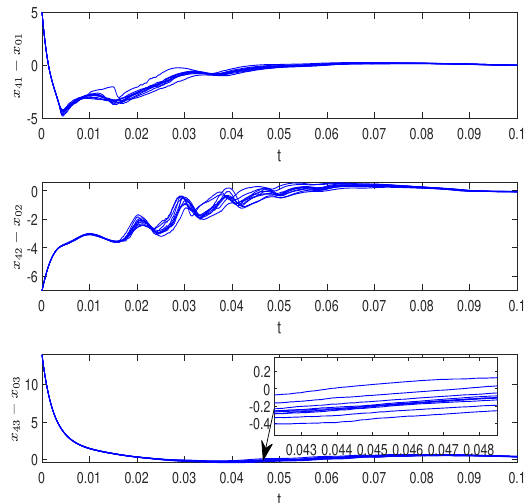
Figure 5. Ten paths of the tracking error between the 4th subchain and the leader with protocol Fig.5. 10 paths of the tracking error between the 4-th subchain and the leader with protocol (4.2).